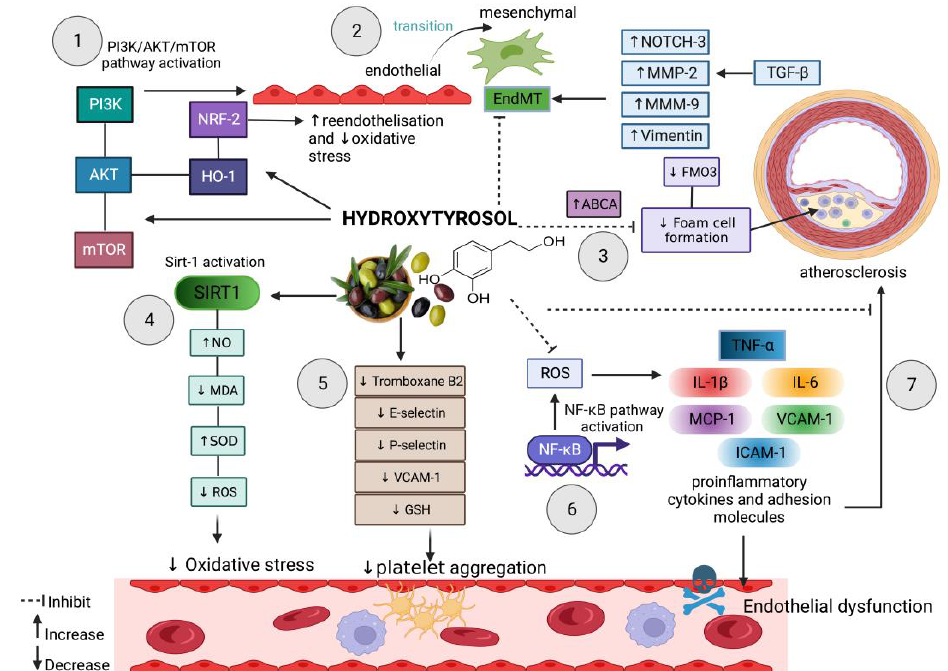
Figure 2. Summary of biomolecules and molecular pathways regulated by hydroxytyrosol in endothelial functioning. (1) HT activates PI3K/AKT/mTOR in re-endothelisation and Nrf2/HO-1 expression in promoting re-endothelisation and decreasing oxidative stress. (2) HT inhibits TGF- β - induced EndMT transition. (3) HT regulates the reverse cholesterol transport pathway by increasing (ABCA1) and decreasing FMO3. (4) HT suppresses oxidative stress by activation of SIRT1. (5) HT lowers platelet aggregation by suppressing adhesion molecules. (6) HT inhibits NF-k β -induced ROS which subsequently triggers the production of pro-inflammatory cytokines and adhesion